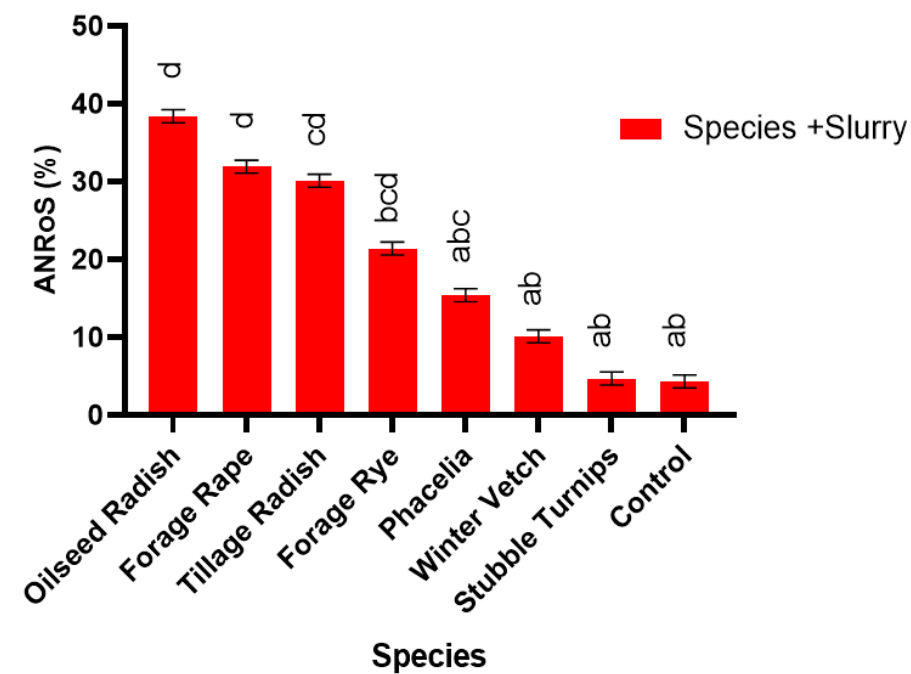
Figure 6. Apparent Nitrogen Recovery (ANRoS) of the species in response to slurry (%). The bars represent the species mean ANRoS in response to slurry (N = 3). Error bars represent Standard Error of the Mean (SEM). Letters represent significant differences between cover crops using Fisher’s Unprotected post-hoc test 0.05 LSD = 16.27. Means that do not share the same letters are significantly ( p < 0.05) different.